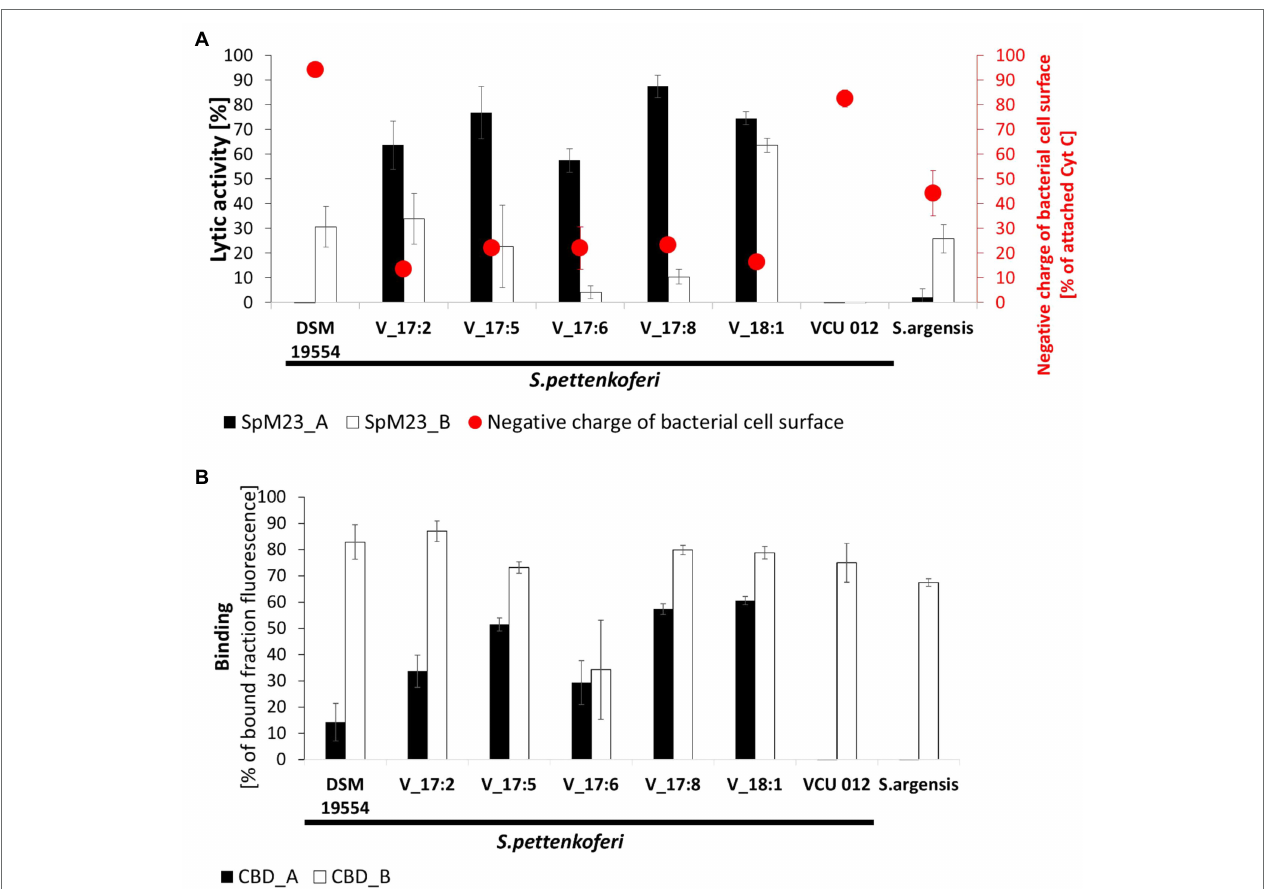
FIGURE 3 | The lytic and binding specificities of SpM23_A and SpM23_B toward bacterial strains that harbor their respective coding genes. (A) Comparison of the lytic activity and the net charge on the surface of Staphylococcus pettenkoferi strain cells. The net charge was estimated by cytochrome c (Cyt C) assay performed in ammonium acetate buffer, pH 4.6. Lytic activity was measured based on decreases in OD 600 values after 1 h of reaction. Bacteria resuspended in reaction buffer without the addition of the lytic enzyme served as the negative control; the reductions in OD 600 values in this sample were subtracted from the presented values. The assay was performed in 50 mM glycine buffer, pH 8.0. All the experiments were performed three times. (B) A binding assay was performed on a set of S. pettenkoferi strains and S. argensis to compare the binding efficiencies of recombinant CBD_A and CBD_B fused to GFP. The fluorescence of the negative control (GFP alone) was subtracted from the presented results. The assay was performed in PBS, pH 7.2, at room temperature. Fluorescence was measured with excitation at the 488 nM wavelength and emission at the 508 nM